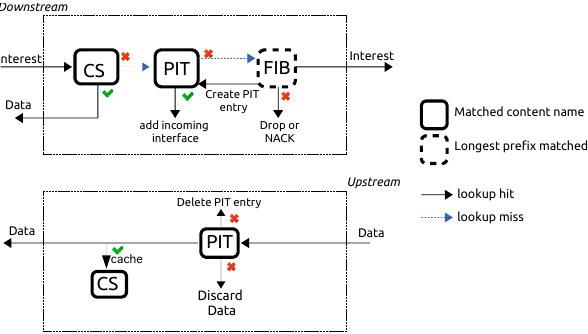
Figure 3. Named data networking forwarding (Adapted from [14]).